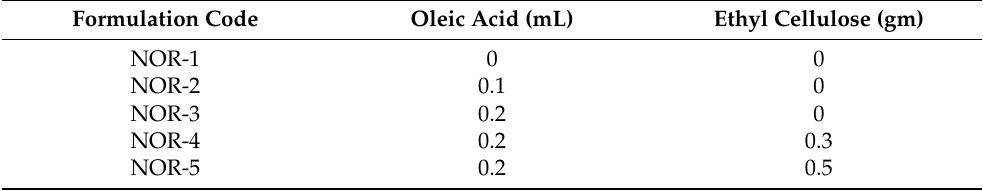
Table 2. Optimization of helper polymer and lipids for hybrid